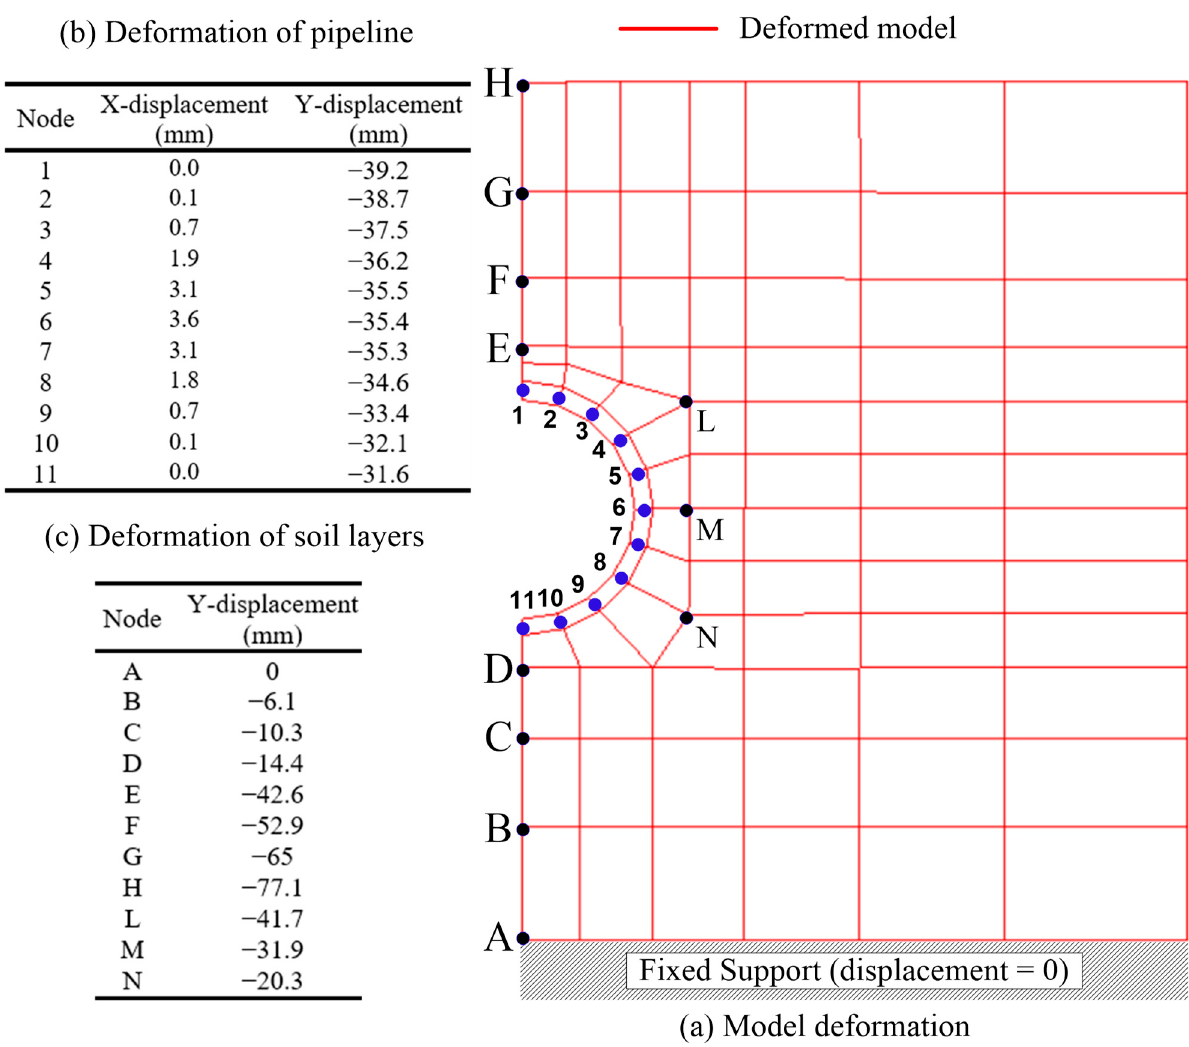
Figure 5. Sample of FEA model results for a soil fill depth of 18.3 m, diameter of 1524 mm, and pipe thickness of 152 mm: ( a ) deformed model, which includes the pipeline elements with nodes 1 to 11 and selected soil nodes A to N, ( b ) nodal displacement of the pipeline structural elements, and ( c ) Y-displacement of selected soil nodes.